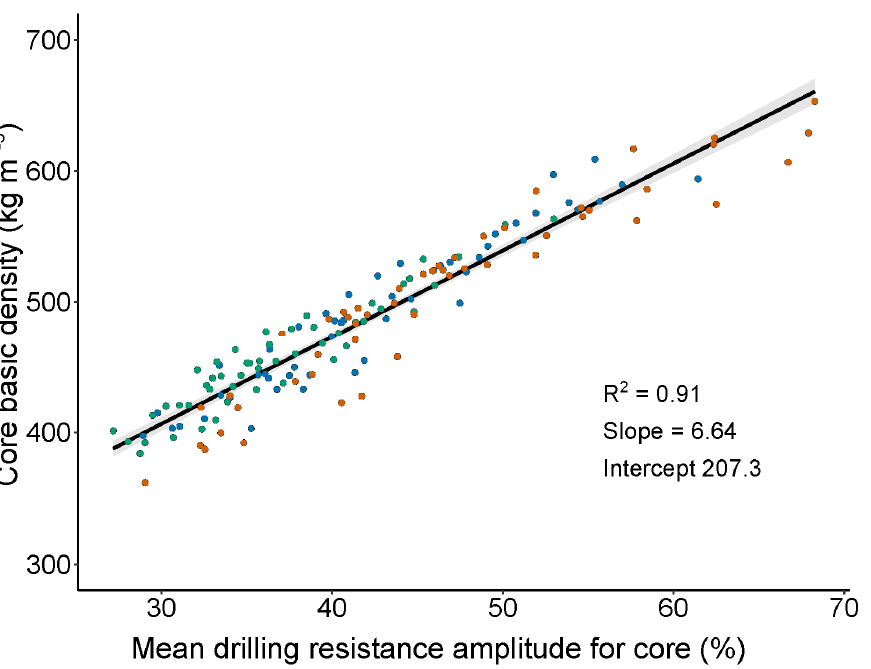
Figure 1. Linear regression between core basic density and mean drilling resistance amplitude across the three thinning sites. Red points are Urana, blue are Florentine and green are Gads.